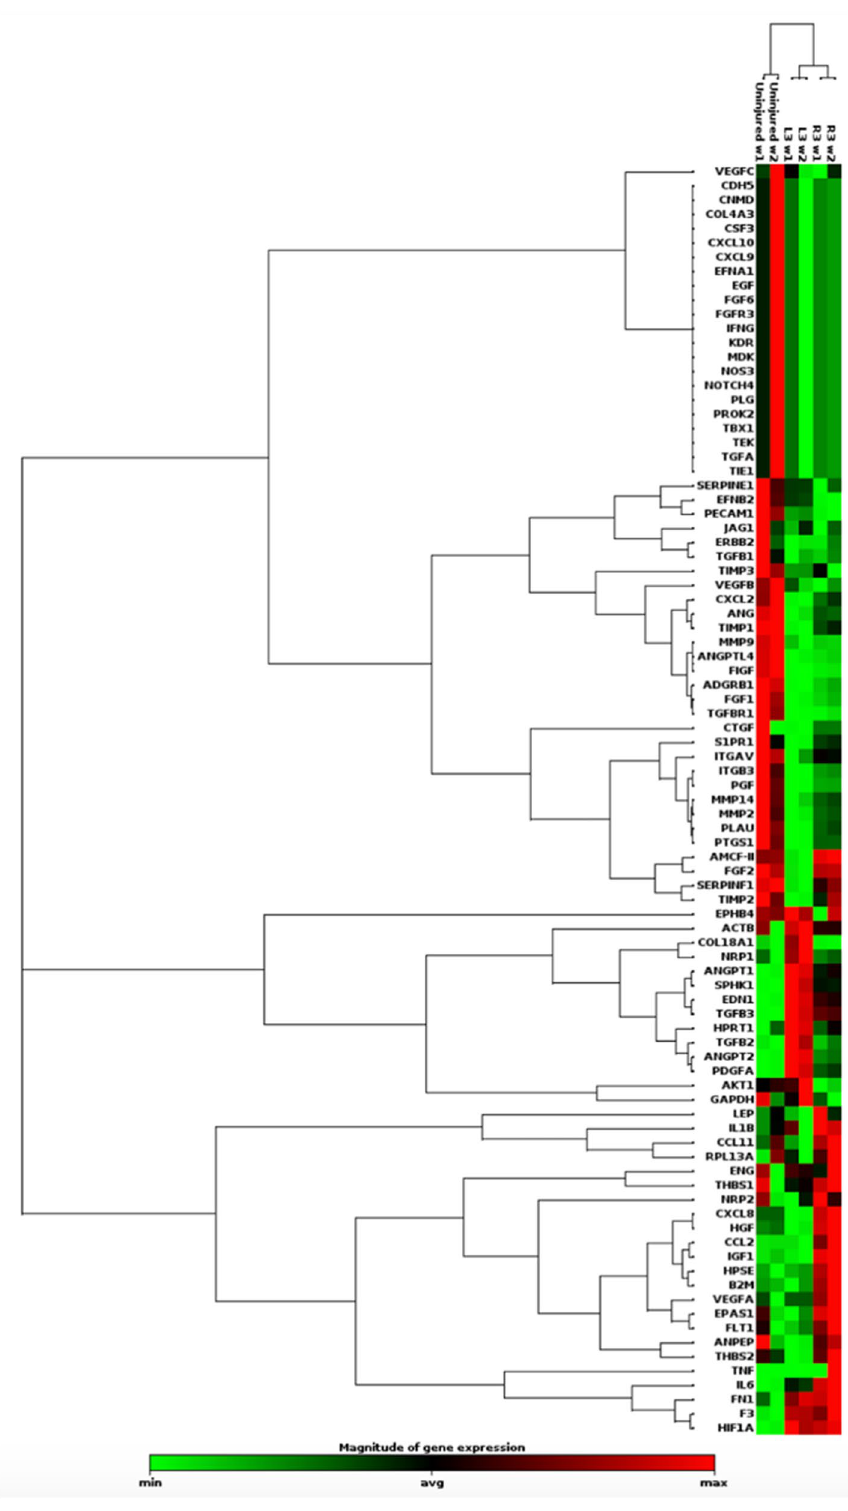
Figure 4. Gene expression in DMVECs differ between burn HTS compared to NS and vary amongst individual HTS. Hierarchical clustergram visually presents gene expression from the PCR array in a heat map format for 2 different scars from animal 1 compared to uninjured skin. Green = upregulation, red = downregulation, black = no detectable